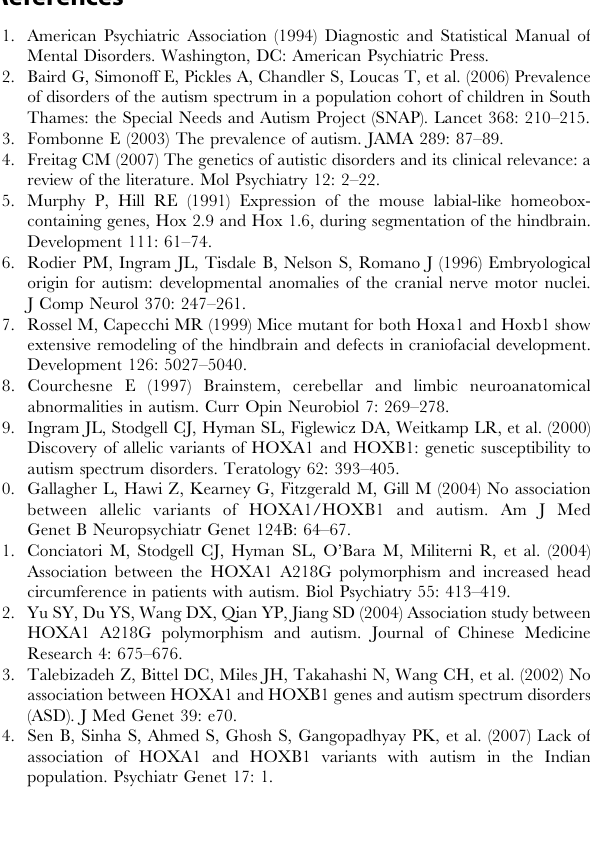
Figure 3. Results of cumulative meta-analysis of association between HOXA1 / HOXB1 variants and ASD risk. (A) Cumulative forest plot for A218G using the random-effects model. (B) Cumulative forest plot for nINS/INS using the fixed-effects